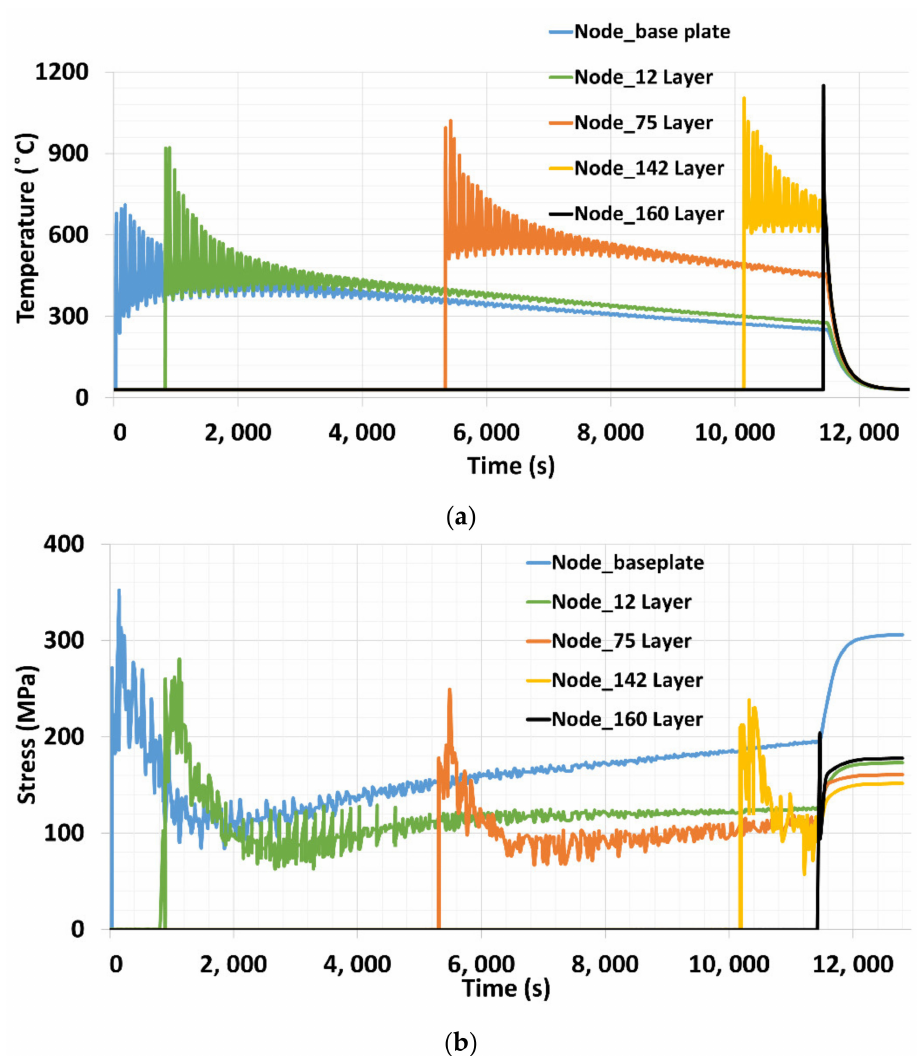
Figure 18. ( a ) Nodal temperature ( b ) Nodal stress at different